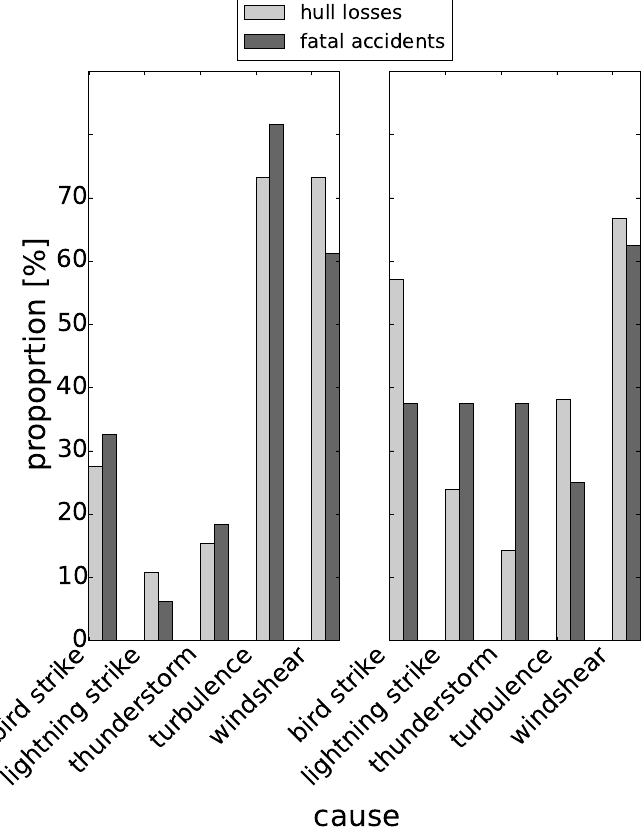
Figure 5. Comparison of different accident causes for the periods 1960–1999 ( left ) and 2000–2015 ( right ) (sources: